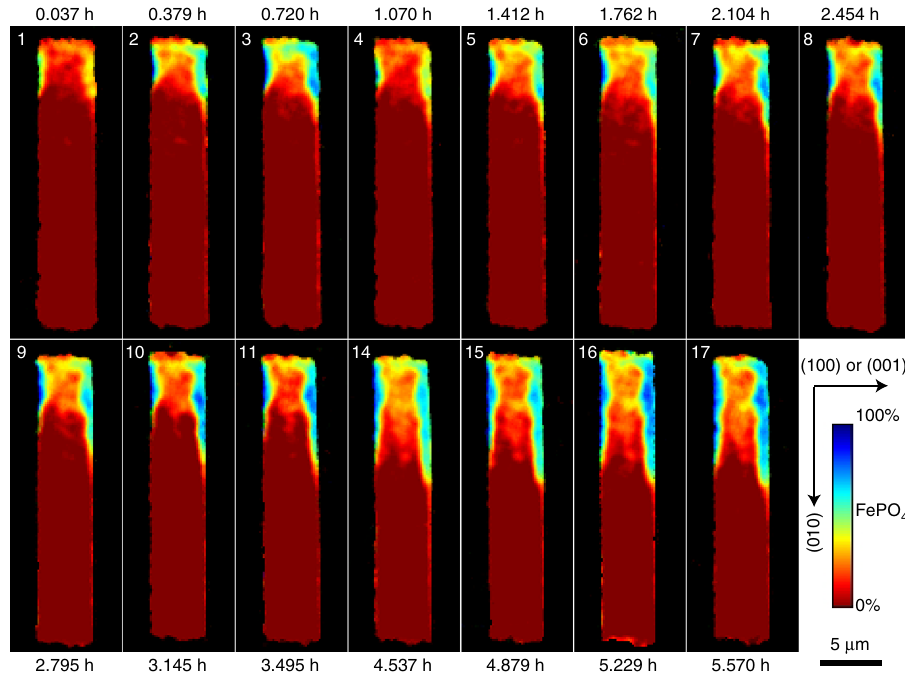
Fig. 3 Operando visualization of delithiation of a single-crystal LiFePO 4 microrod. 2D depth-averaged FePO 4 single-phase chemical maps (58 × 162 pixels; 1 pixel corresponds to ~160 nm) taken at different states of charge show the evolution of the phase state of a LiFePO 4 microrod along different crystallographic directions. The long-axis of the LiFePO 4 microrod is along [010] and its short-axis is along [100] or [001]. The “ jet ” color-scale corresponds to the fraction of the FP phase (red, 0% FePO 4 ; blue, 100% FePO 4 ). All phase maps share the same 5 μ m scale bar. Note that phase map 12 and 13 were not collected because X-ray beam was not available due to synchrotron re fi